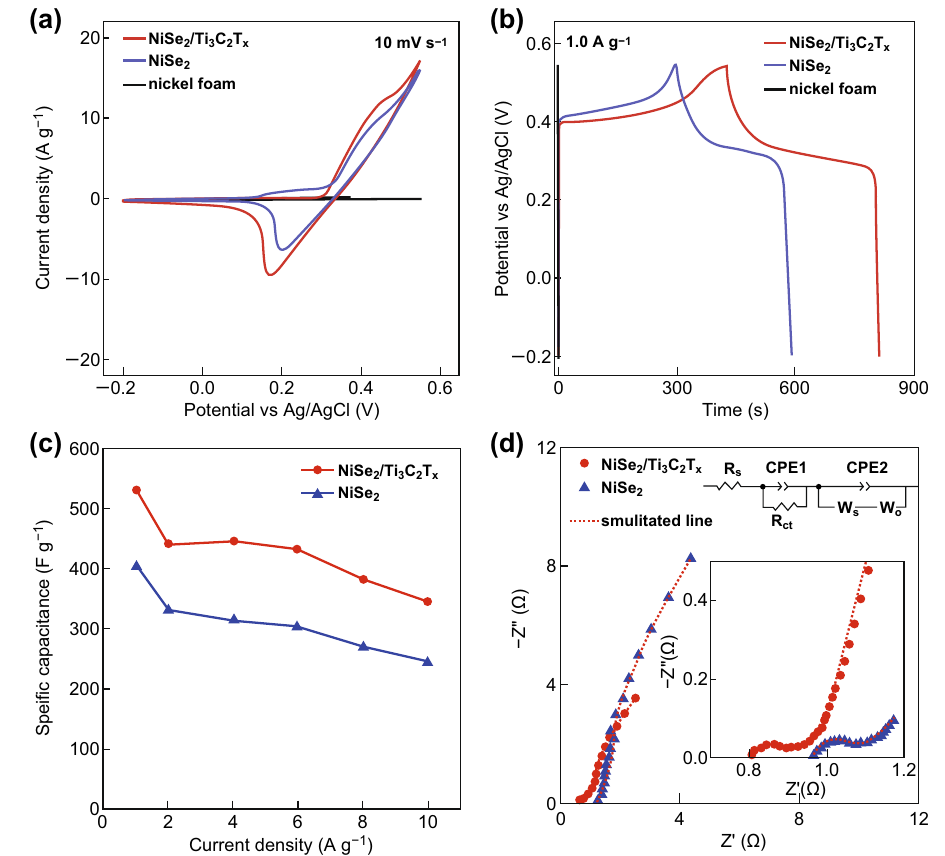
Fig. 3 Supercapacitor performance in 2 M KOH solution: a CV profiles of unmodified NiSe 2 , NiSe 2 /Ti 3 C 2 T x , and bare nickel foam at 10 mV s −1 . b GCD curves of unmodified NiSe 2 , NiSe 2 /Ti 3 C 2 T x , and bare nickel foam at 1.0 A g −1 . c Variation of specific capacitances with current density for unmodified NiSe 2 and NiSe 2 /Ti 3 C 2 T x . d Nyquist plots of unmodified NiSe 2 and NiSe 2 /Ti 3 C 2 T x in the range of 10 mHz to 100 kHz (inset is the high‑frequency region and the equivalent circuit used to fit the experimental